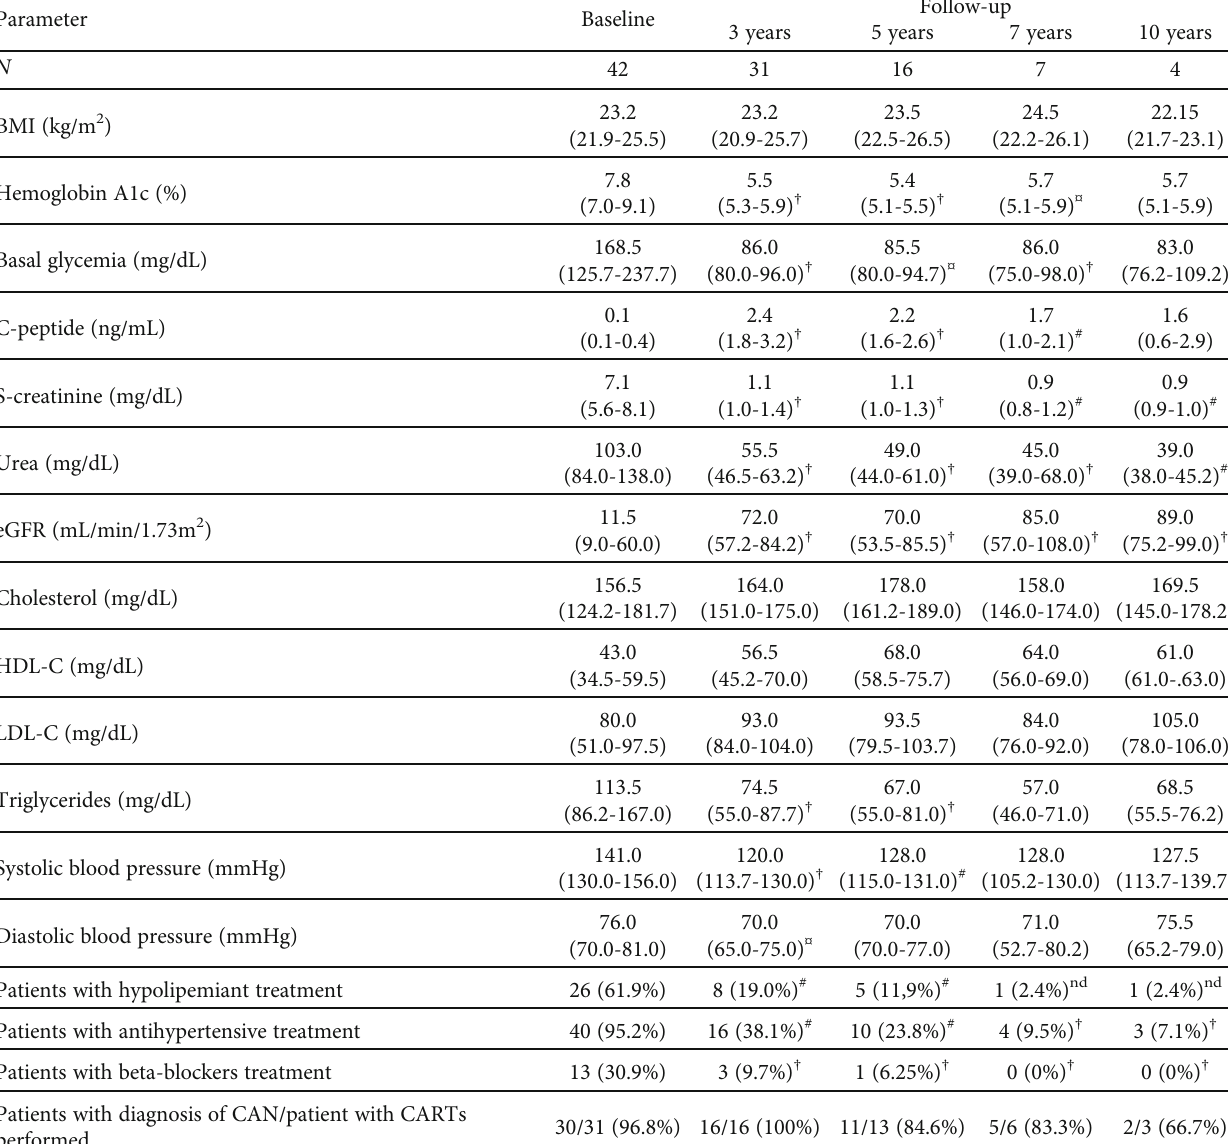
Table 1: Paired tests for the baseline and post-SPK follow-up characteristics in SPK recipients.